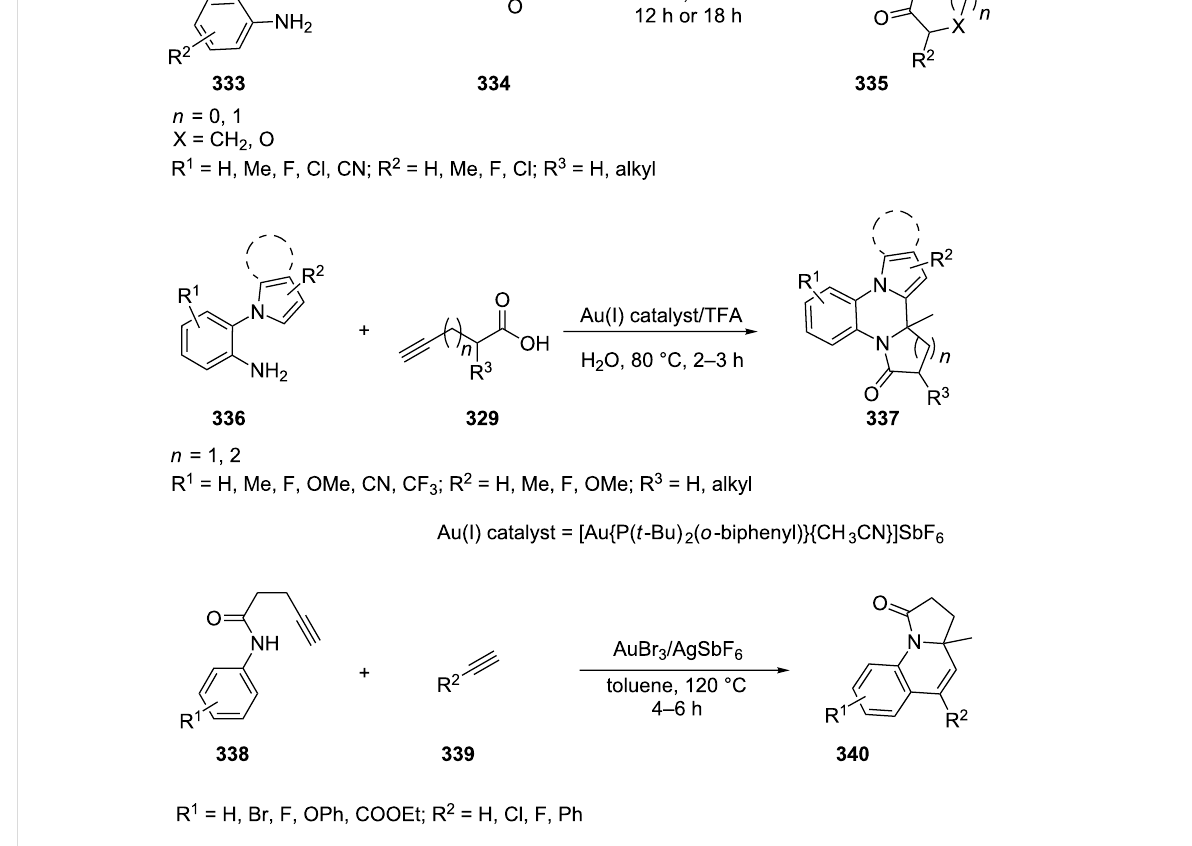
Scheme 56: Gold-catalyzed tandem reactions of